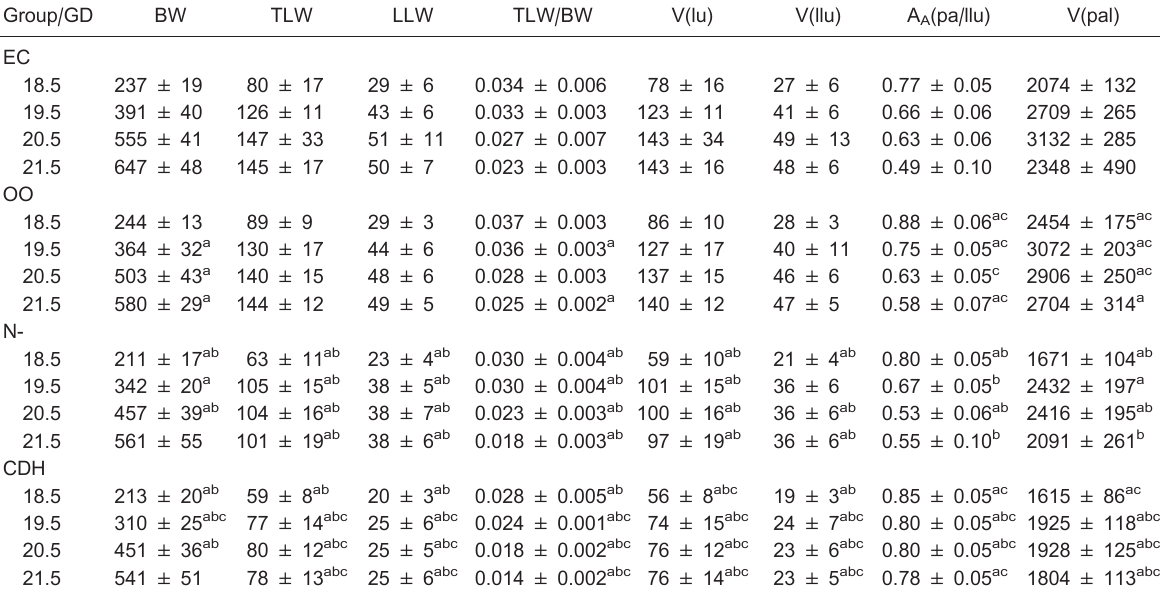
Table 1. Morphological variables of